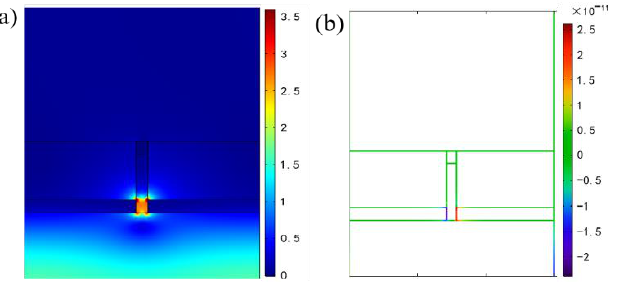
Figure 10. Electric field and charge distributions in the near infrared region at θ = 10° with TM polarized incidence from the bottom of single layer Ag film grating. ( a ) Normalized spatial electric field distribution at a typical resonant wavelength of λ = 1450 nm; ( b ) The corresponding charge distribution at λ = 1450 nm.